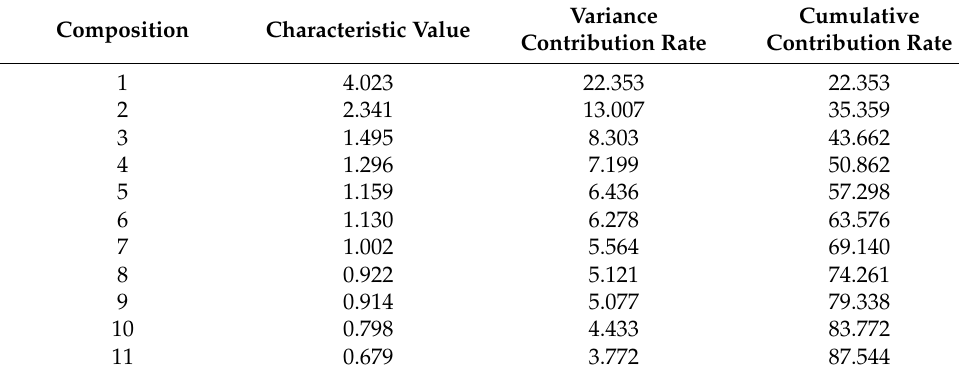
Table 3. Results of principal component